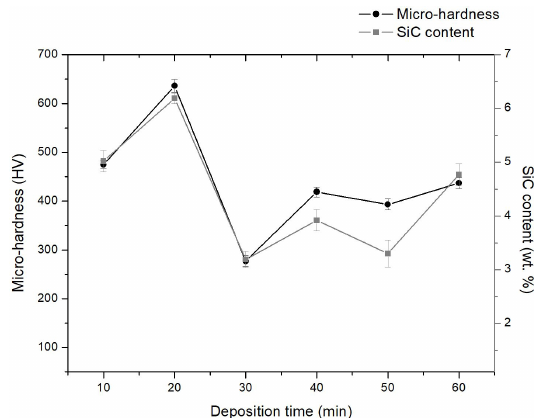
Figure 6. Effect of deposition time on micro-hardness and on the content of SiC nanoparticles on the surface of the Ni-Co/SiC nanocomposite